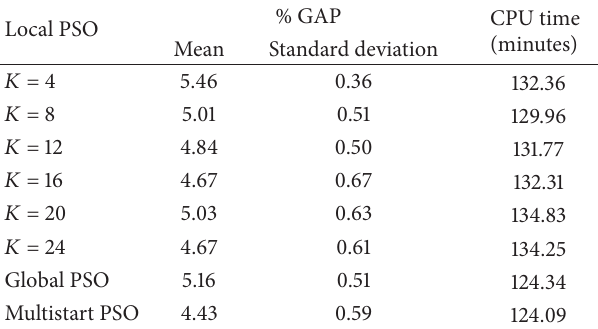
Table2:NumericalresultsofdifferentvariantsofthePSOalgorithm in the case of problem 1.